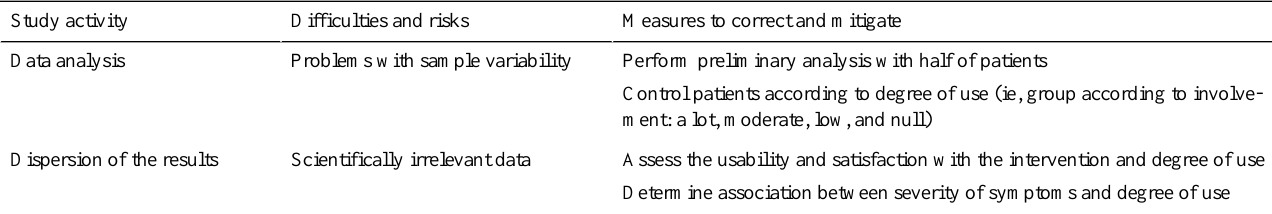
Table 6. Difficulties associated with activities of study analysis and results and their correction